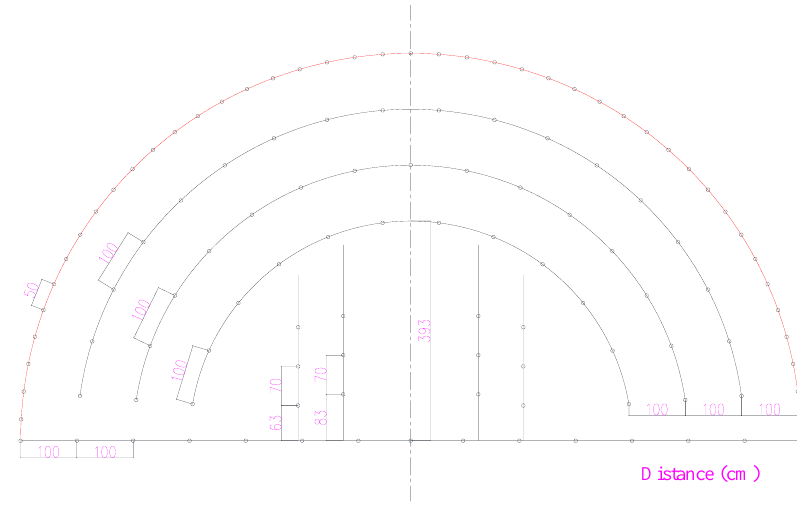
Figure 9. Numerical model with joints of bedded tunnel.